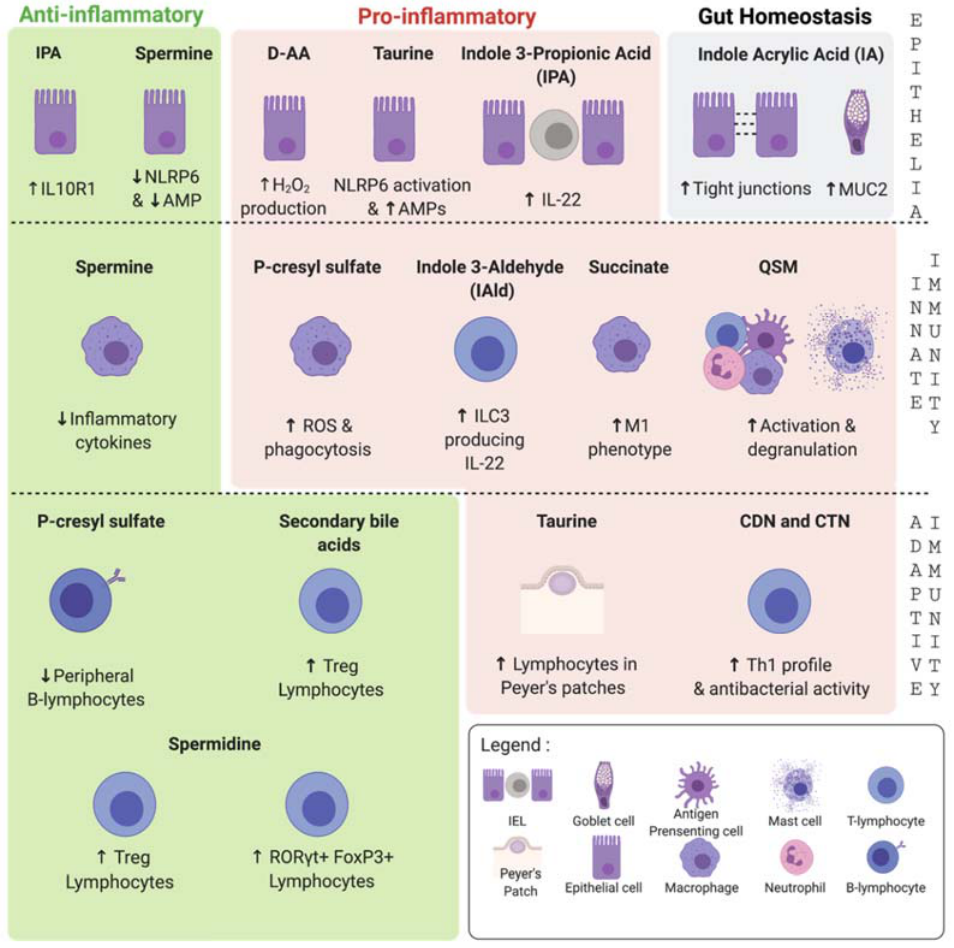
Figure 3. Summary of the immunomodulatory properties of the main described soluble metabolites on epithelial cells, as well as on innate and adaptive immune cells. D-AA, Stereoisomer D-amino acids; QSM, Quorum Sensing Molecules; CDN, Cyclic-DiNucleotides; CTN, Cyclic TriNucleotides. Taurine